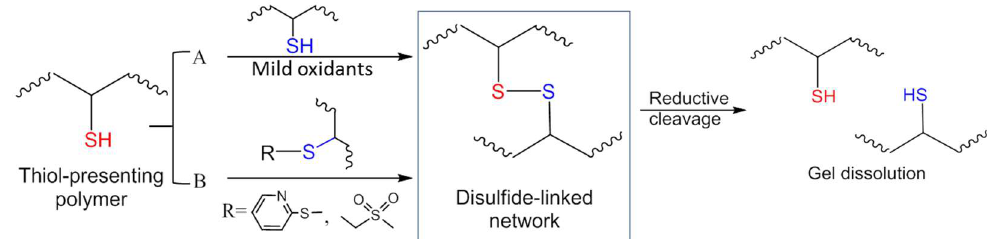
Figure 2. Strategies of disulfide bond formation for in situ crosslinking of polymer hydrogels. ( A ) Mild oxidation of thiols. ( B ) Thiol-disulfide exchange (a substitution reaction). The disulfide-crosslinked network can break down when treated with reductive agents (e.g., soluble